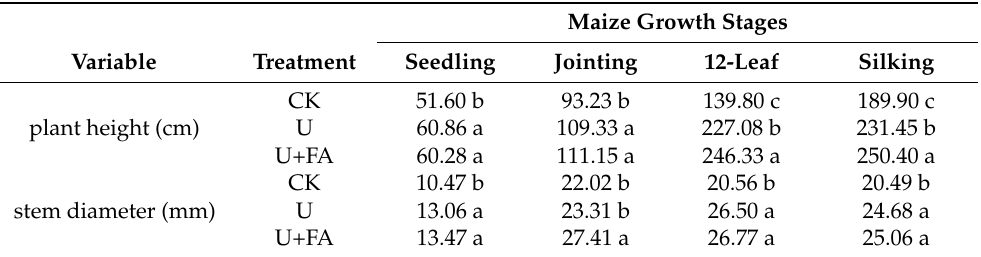
Table 4. Effects of different fertilization treatments on plant height and stem diameter at the different growth stages of maize, in 2017.